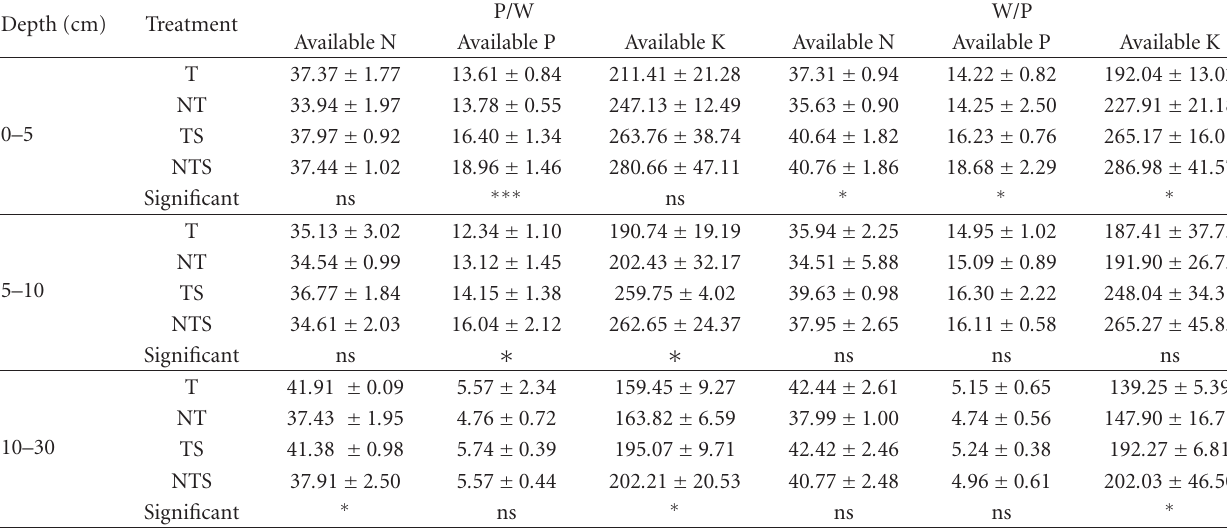
Table 4: Soil available nutrients as a ff ected by stubble management in di ff erent rotation sequence (mgkg − 1 ). Depth